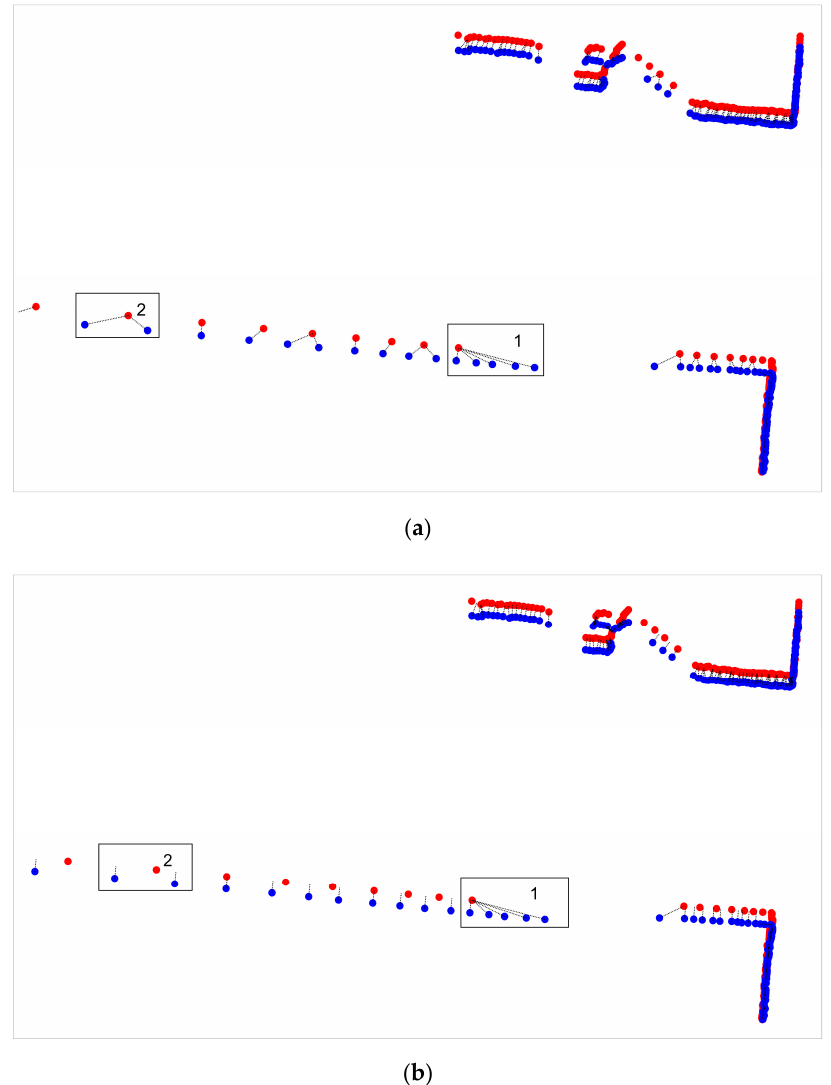
Figure 6. ( a ) Correspondences that were established based on the point-to-point metric (red dots-reference scan, blue dots-object scan, black lines-correspondences); ( b ) correspondences that were established based on the point-to-line metric (red dots-reference scan, blue dots-object scan, black lines-correspondences).